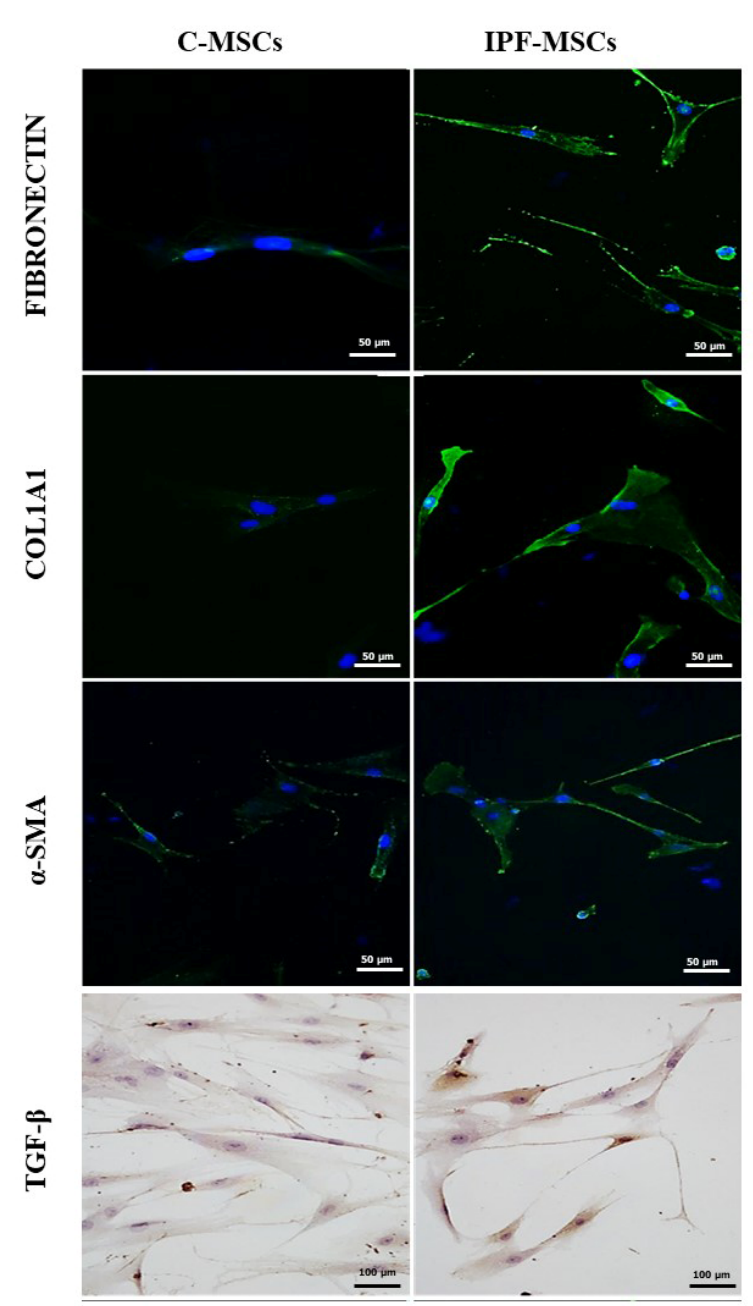
Figure 3. α -SMA, collagen type 1, fibronectin, and TGF- β 1 expression. Indirect immunofluorescence (IIF) analysis of α -SMA, collagen type 1 (COL1A1), and fibronectin and immunocytochemical (ICC) analysis of TGF- β 1 performed on mesenchymal stem cells (MSCs) derived from control (C-MSCs) and idiopathic pulmonary fibrosis (IPF-MSCs) tissues. For IIF, a secondary FITC-conjugated antibody was used after incubation with the primary antibodies. Nuclei were counterstained with Hoechst 33342. For ICC of TGF- β 1, slides were treated with 3,3-diaminobenzidine and counterstained with Mayer’s hematoxylin.